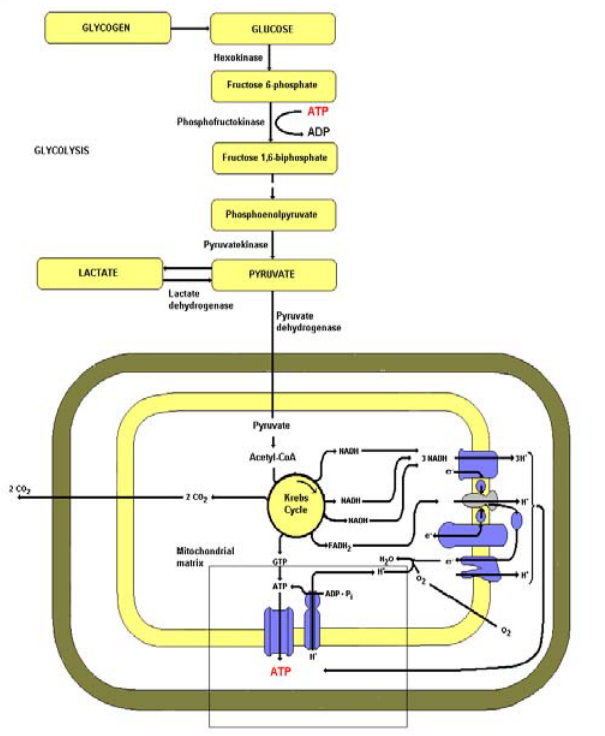
FIGURE 1. Main phases of energy metabolism. Glycolysis: glucose is converted to pyruvate. Pyruvate can be metabolized either to lactate to produce 2ATP, or enter the citric acid cycle to produce 36